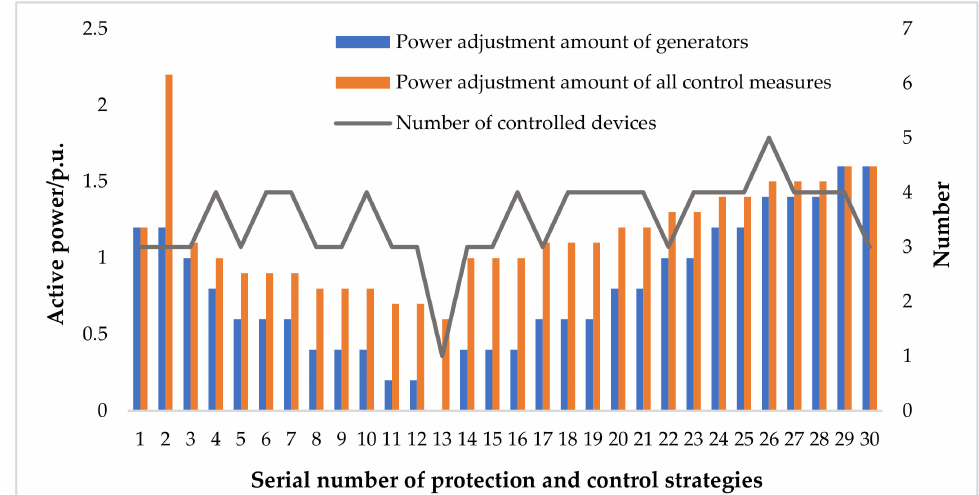
Figure 9. Comparison of protection and control